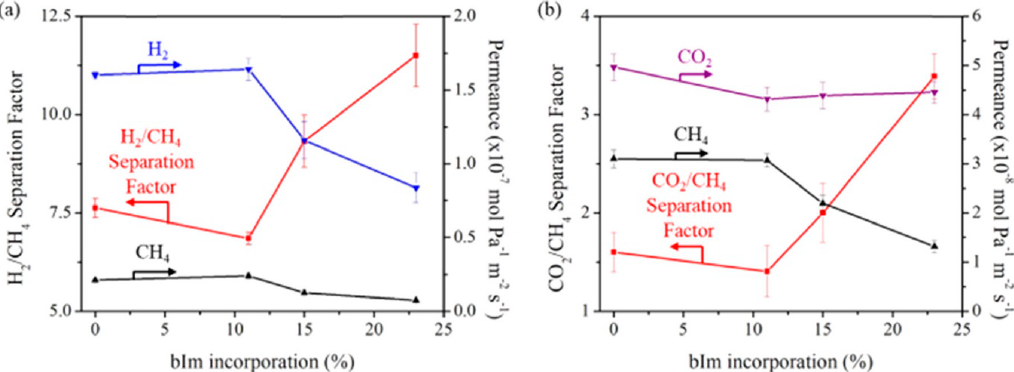
Figure 56. Binary testing of ( a ) H 2 /CH 4 and ( b ) CO 2 /CH 4 for ZIF-7-8 membranes with varying bIm incorporation (adapted with permission from ref. [66]).